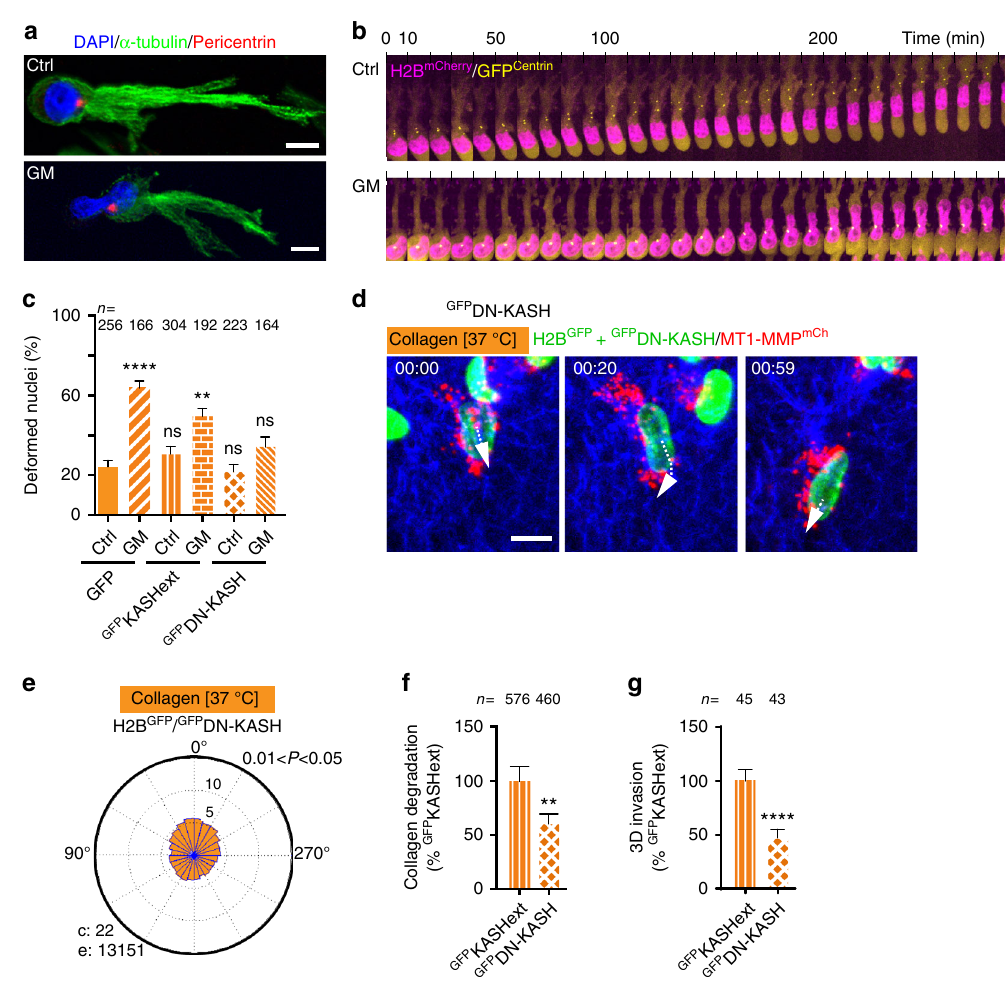
Fig. 3 Nucleus-centrosome linkage through LINC complex is involved in MT1-MMP endosome polarization and collagenolysis-based invasion. a MDA-MB- 231 cells in 3D collagen I polymerized at 37 °C treated or not with GM MMP inhibitor and stained for α -tubulin (green), centrosomal pericentrin (red) and nucleus (blue). b Galleries from representative time-lapse sequences of MDA-MB-231 cells expressing H2B mCherry (magenta) and GFP Centrin-1 (yellow) invading through type I collagen gel as in a . c Morphological analysis of DAPI-stained nuclei as in Fig. 1d. Data are mean % ± SEM from three independent experiments. ( n ), number of cells analyzed. P -values of Kruskal – Wallis test as compared to non-treated GFP-expressing cells. d Representative frames of a movie of MDA-MB-231 cells expressing MT1-MMPmCh (red) and H2B GFP together with GFP DN-KASH (green) invading through the small pore size collagen gel polymerized at 37 °C (see time-lapse sequence in Supplementary Movie 5). e Rose plots of endosome angular distribution from three independent experiments as in Fig. 2b. P -value for circular uniformity Rao ’ s Spacing test is provided. f Pericellular collagenolysis by MDA-MB-231 cells expressing GFP DN-KASH in 37 °C polymerized gel normalized to mean intensity of GFP KASHext-expressing cells ± SEM (see Supplementary Fig. 4e for representative images); n , number of cells analyzed from three independent experiments; Mann – Whitney test. g 3D invasion of GFP DN-KASH-expressing cells in the small pore size gel normalized to invasion of GFP KASHext-expressing cells ± SEM from three independent experiments as in Fig. 1l. n number of cells analyzed from three independent experiments (see Supplementary Fig. 4f for representative images); Mann – Whitney test. ** P < 0.01; **** P < 0.0001; ns non signi fi cant. Scale bars = 10 µ